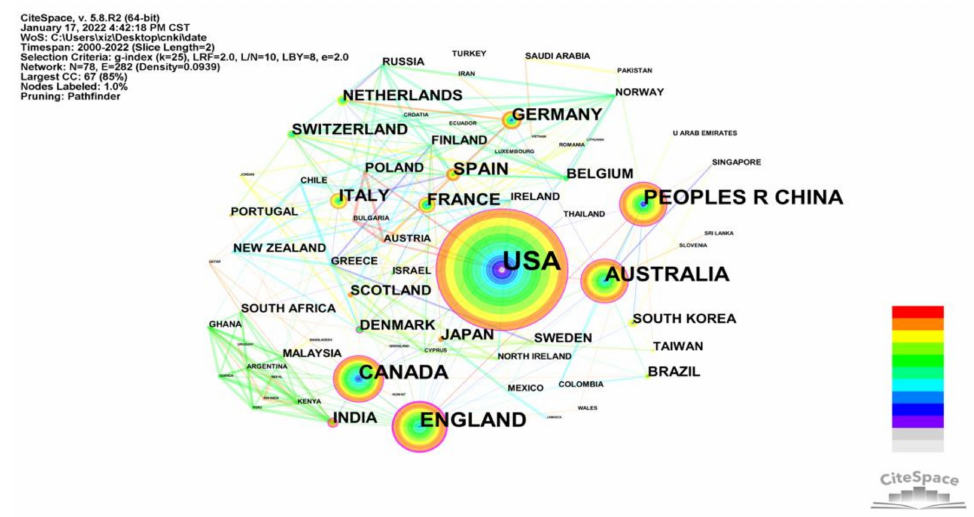
Figure 5. Knowledge map of the inter-country/inter-region network.